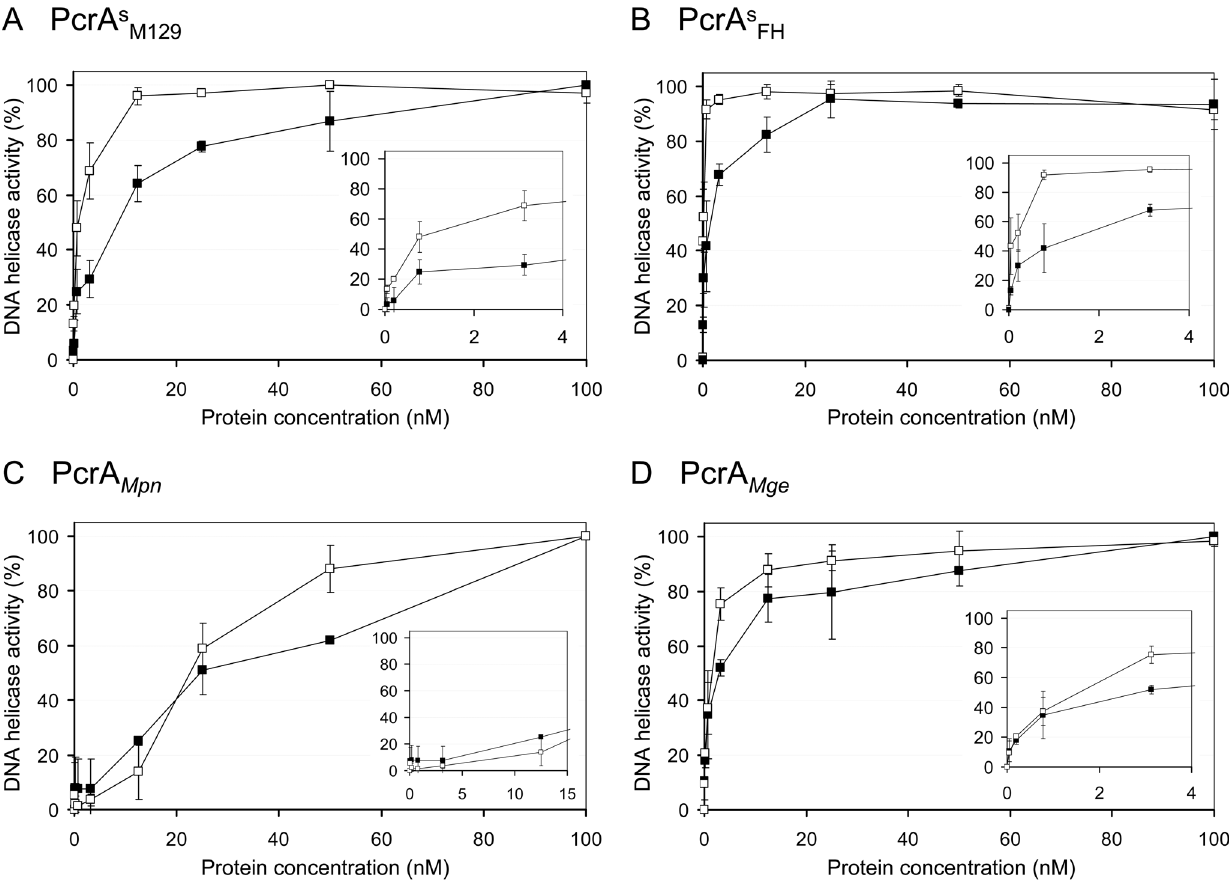
Figure 5. Protein concentration-dependence of the DNA helicase activities of the PcrA proteins. Reactions were carried out in a similar fashion as described in Fig. 4, and contained 4 nM of either substrate ‘a’ ( % ) or ‘b’ ( & ) and a range of concentrations of either PcrA s M129 (A), PcrA s FH (B), PcrA Mpn (C) or PcrA Mge (D). The protein concentrations tested were 0 pM, 50 pM, 0.2 nM, 0.8 nM, 3.2 nM, 12.5 nM, 25 nM, 50 nM and 100 nM. DNA unwinding was quantified by determination of the percentage of free (labeled) oligonucleotide that was displaced from the DNA substrates.